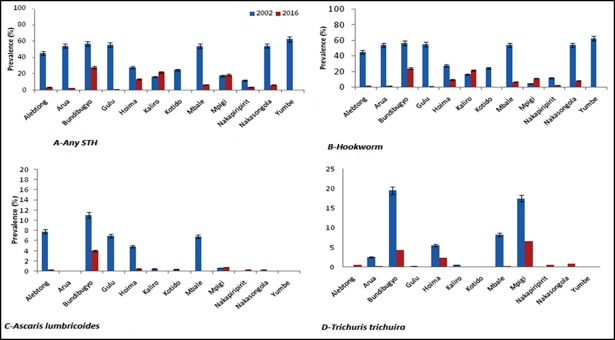
Showing comparisons of the prevalence of infections between baseline 2002 and follow-up in 2016.